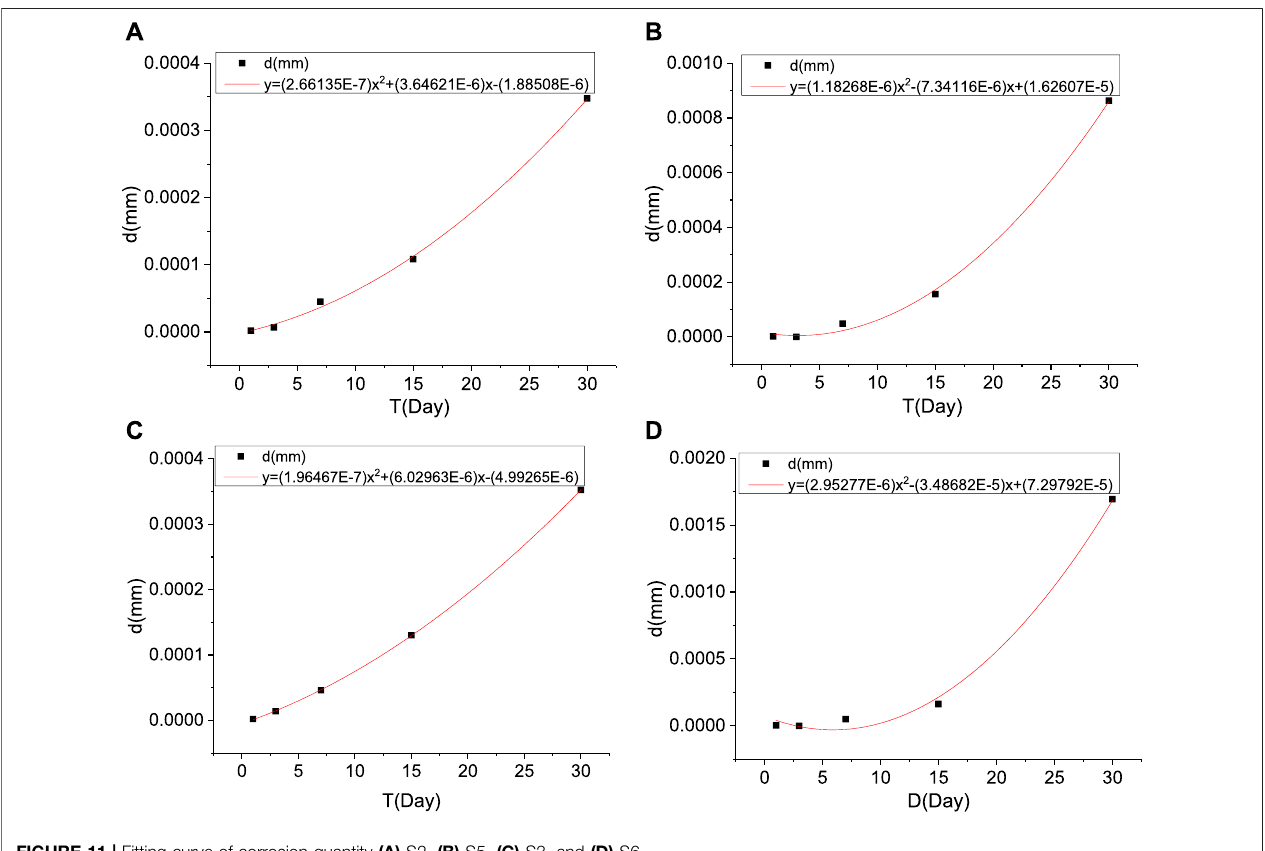
FIGURE 11 | Fitting curve of corrosion quantity (A) S2, (B) S5, (C) S3, and (D) S6.